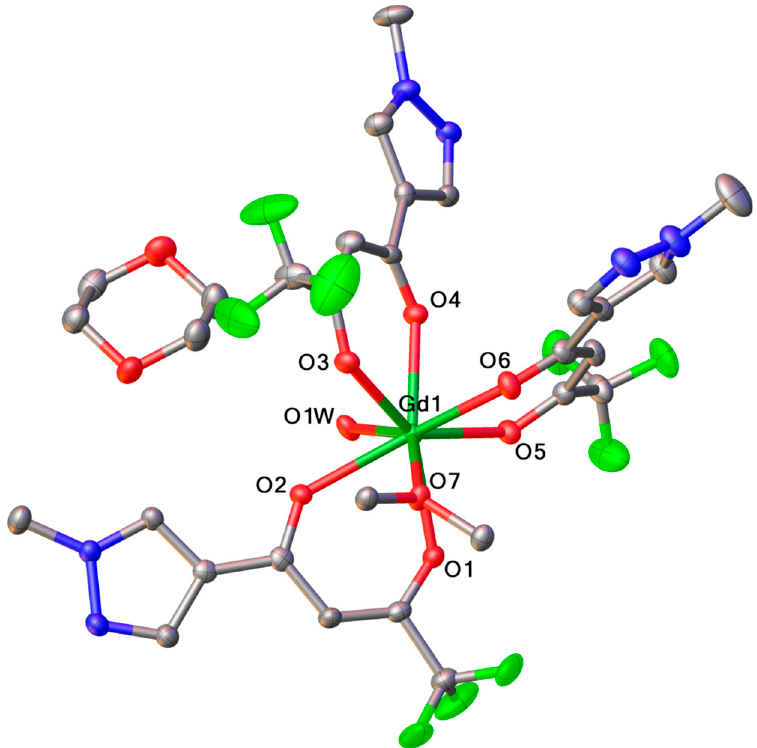
Figure 1. View of the asymmetric unit of 2 crystal. Thermal ellipsoids are presented at 50% probability, and hydrogen atoms are omitted for clarity.